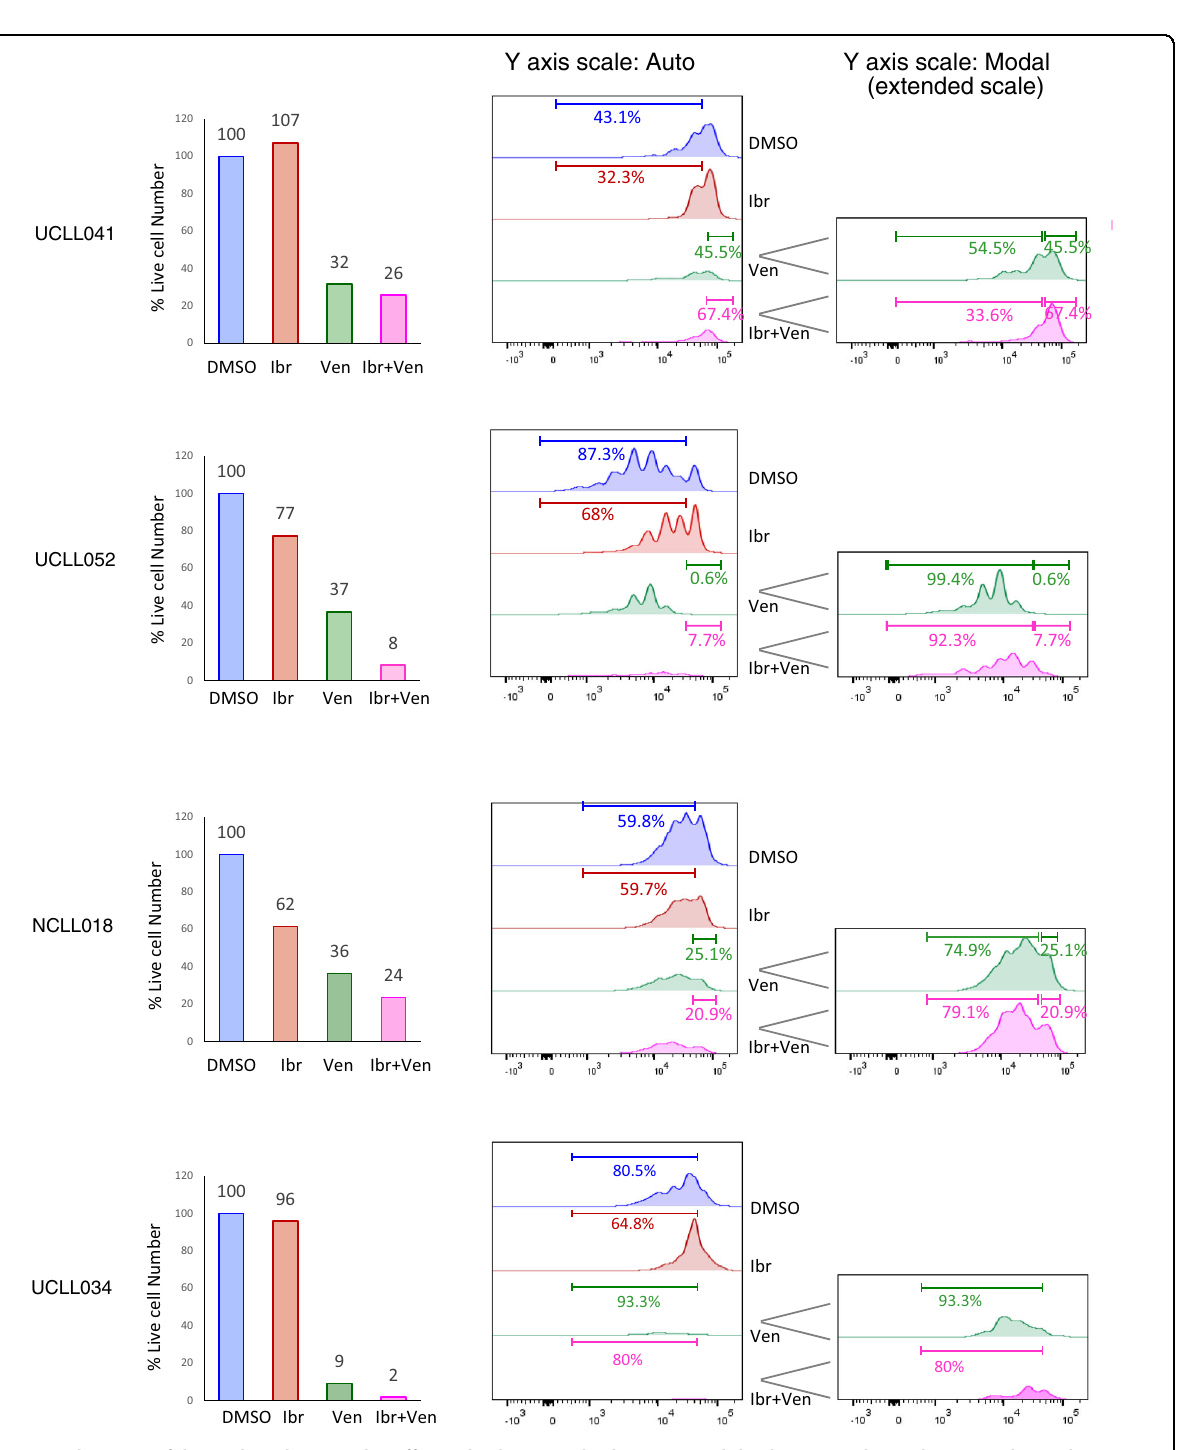
populations (Figs. 4 and 5, green traces).